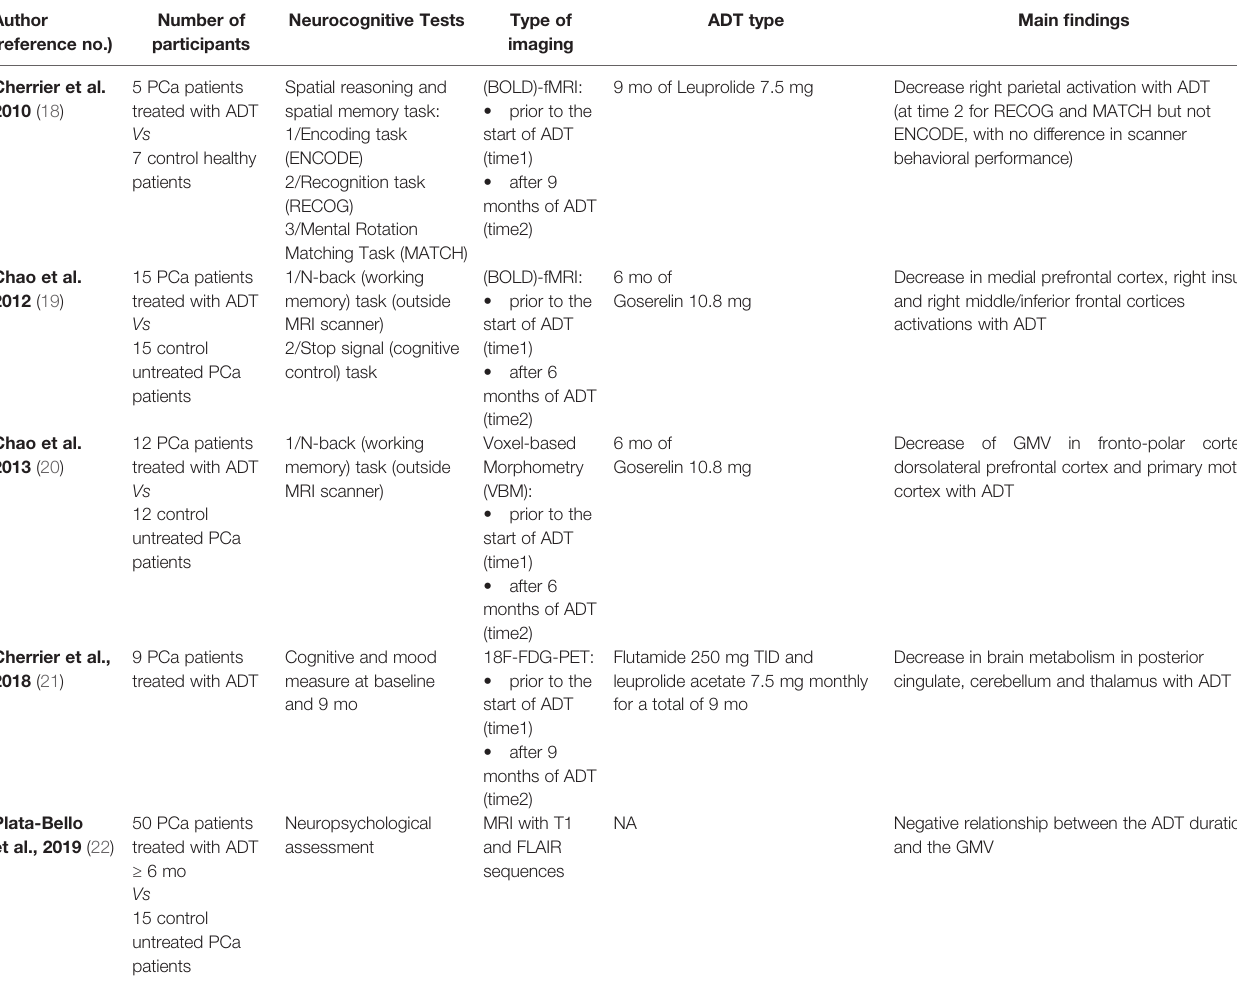
TABLE 2 | Imaging studies investigating changes in neuronal activation in response to androgen deprivation therapy in prostate cancer patients. Author (reference